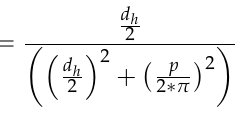
Figure 6. Comparison of characterization results for ( a – c ) helical-fiber nonwoven sample and ( d – f ) nonwoven sample with straight fiber, where ( a , d ) are fiber orientation distributions; ( b , e ) are helix diameter distributions; ( c , f ) are curvatures of helix distributions. To verify the characterization of fiber diameter, which is 0.6 μ m for the helical-fiber nonwoven sample and 0.22 μ m for the sample with straight fibers, DiameterJ plugin [27], which is an open source for nanofiber diameter measurement tool, was used to analyze the two samples. The results (0.57 μ m for the helical-fiber sample and 0.19 μ m for the sample with straight fibers) turn out to be in accordance with the results using our method. Figure 6a,d shows that the orientation distributions of fibers for the two samples have similar characteristic and present the anisotropy of the nonwovens. Figure 6b,e shows the helix diameter distributions of fibers for the two cases. The fiber helix diameters of the helical-fiber nonwoven sample are in the range of 0.25–1.5 μ m, with the average diameter of 0.6 μ m. As expected, the helix diameter frequency of the sample with straight fibers is 0.